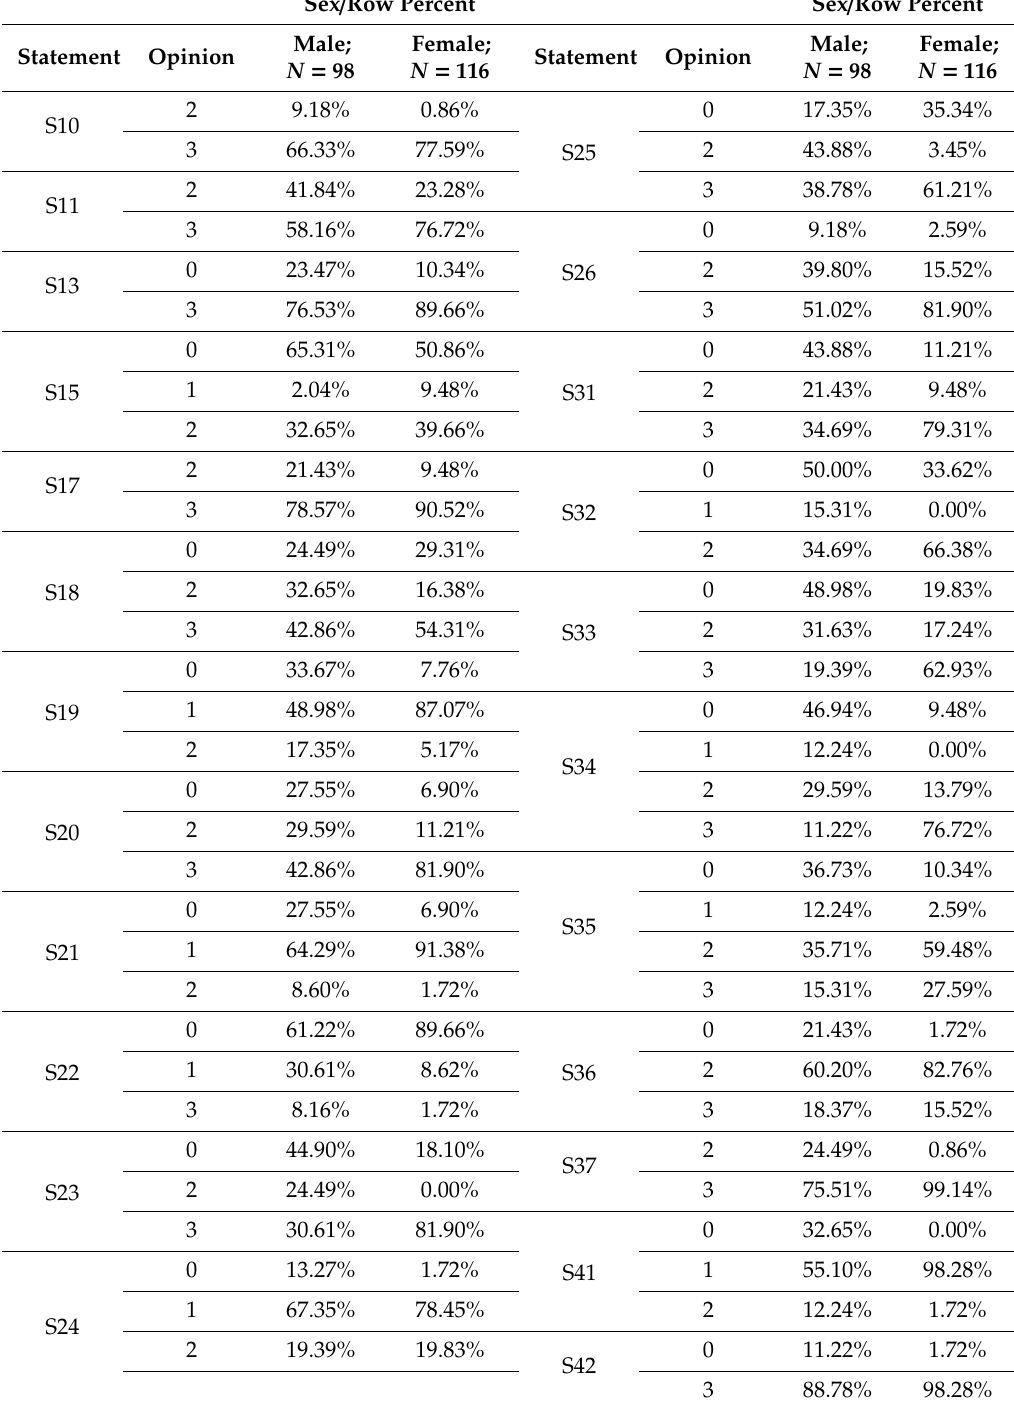
Table 2. Table 5. Gender as a factor significantly influencing opinions and attitudes to